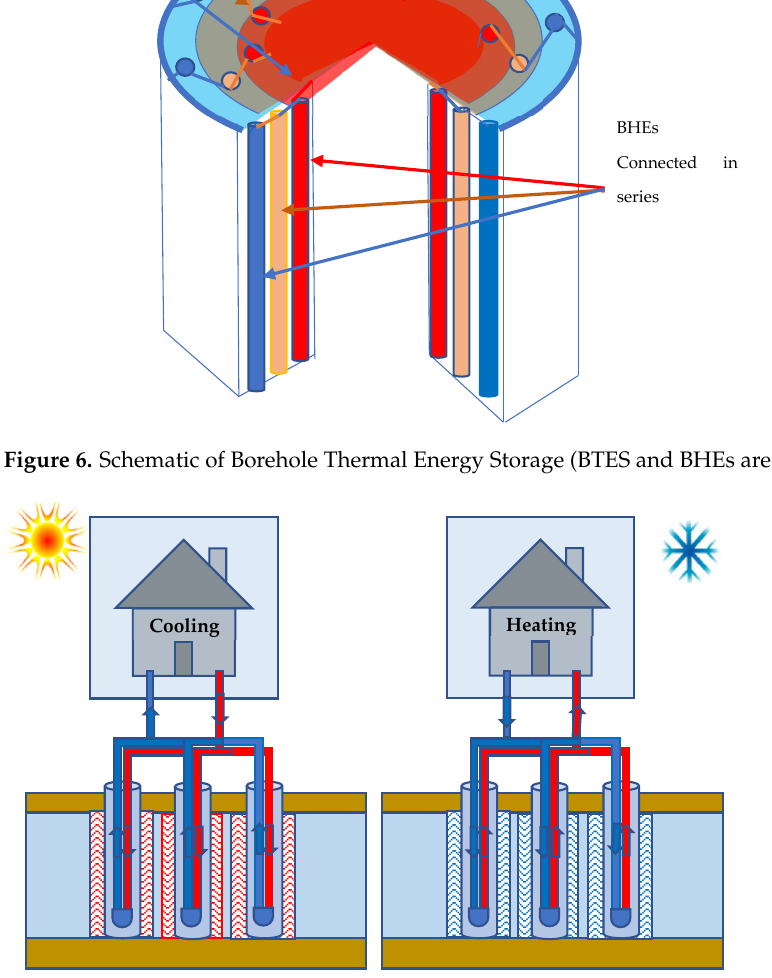
Figure 7. Schematic of Borehole Thermal Energy Storage (BTES), BHEs are connected in parallel.